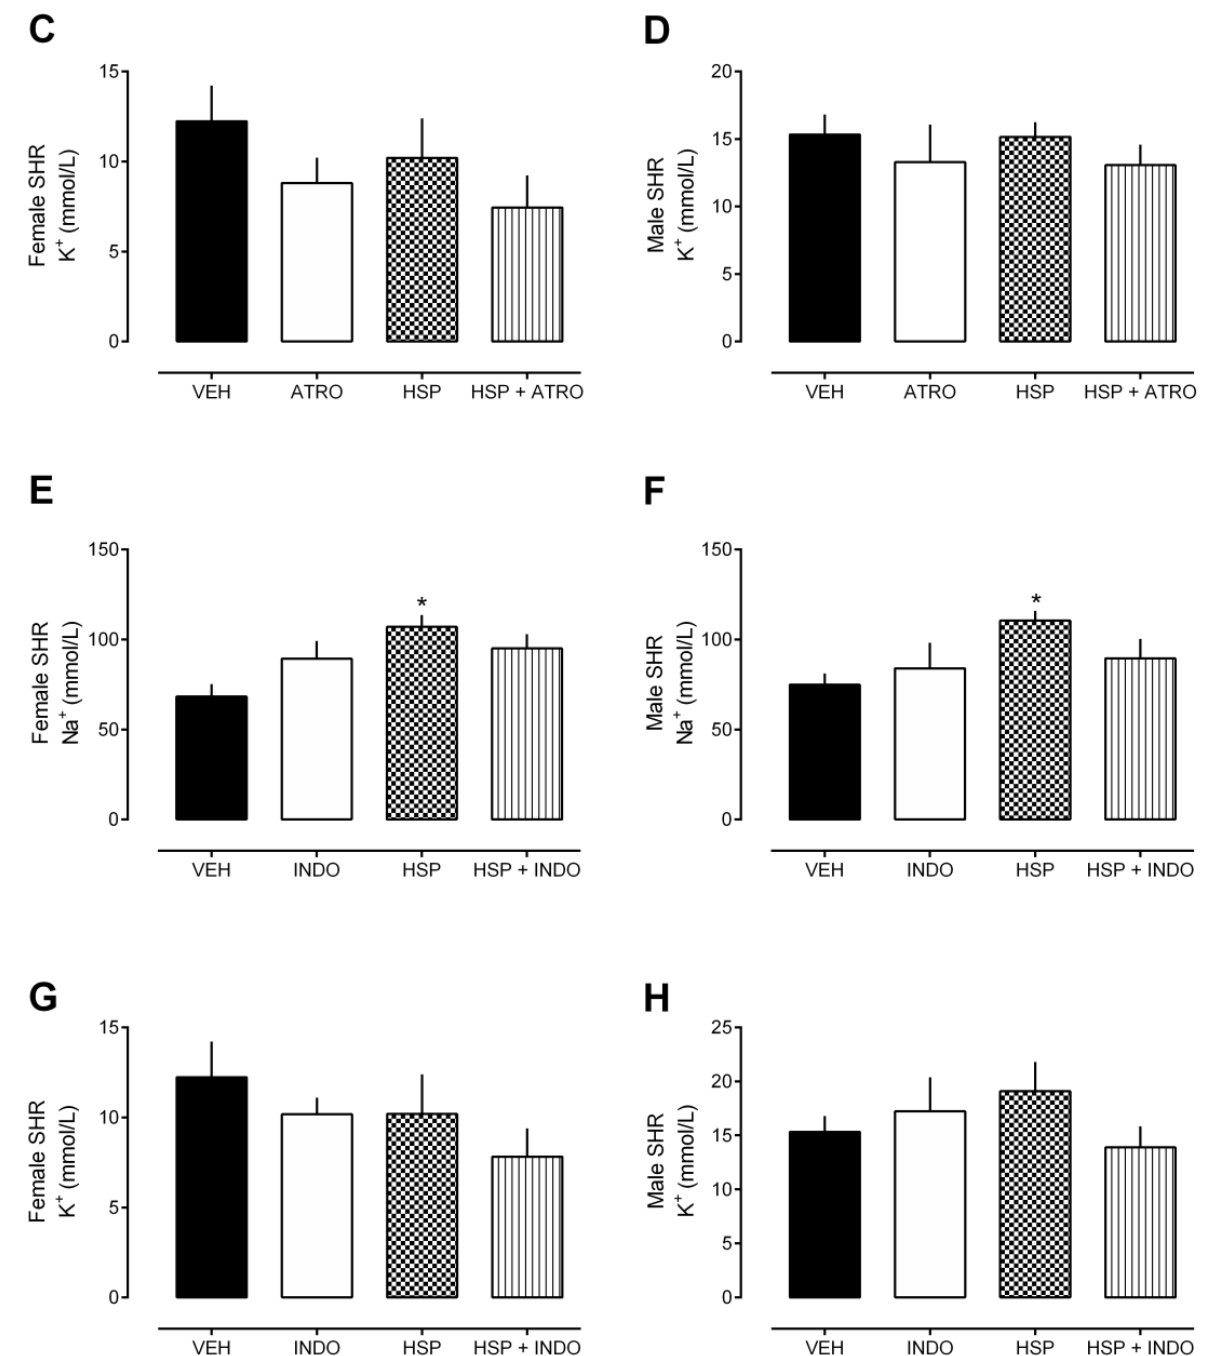
Figure 6. Urinary parameters (8 h) after oral treatment with hesperidin (HSP) in the presence of atropine (ATRO) or indomethacin (INDO). ( A , B ) Urine Na + excretion after treatment with HSP in the presence of ATRO. ( C , D ) Urine K + excretion after treatment with HSP in the presence of ATRO. ( E , F ) Urine Na + excretion after treatment with HSP in the presence of INDO. ( G , H ) Urine K + excretion after treatment with HSP in the presence of INDO. The values show the mean ± SEM. Statistical analysis was performed by means of one-way ANOVA followed by Dunnett’s multiple comparisons test. * p < 0.05 when compared with the VEH (vehicle; saline 10 mL/kg); # p < 0.05 when compared with the HSP-only